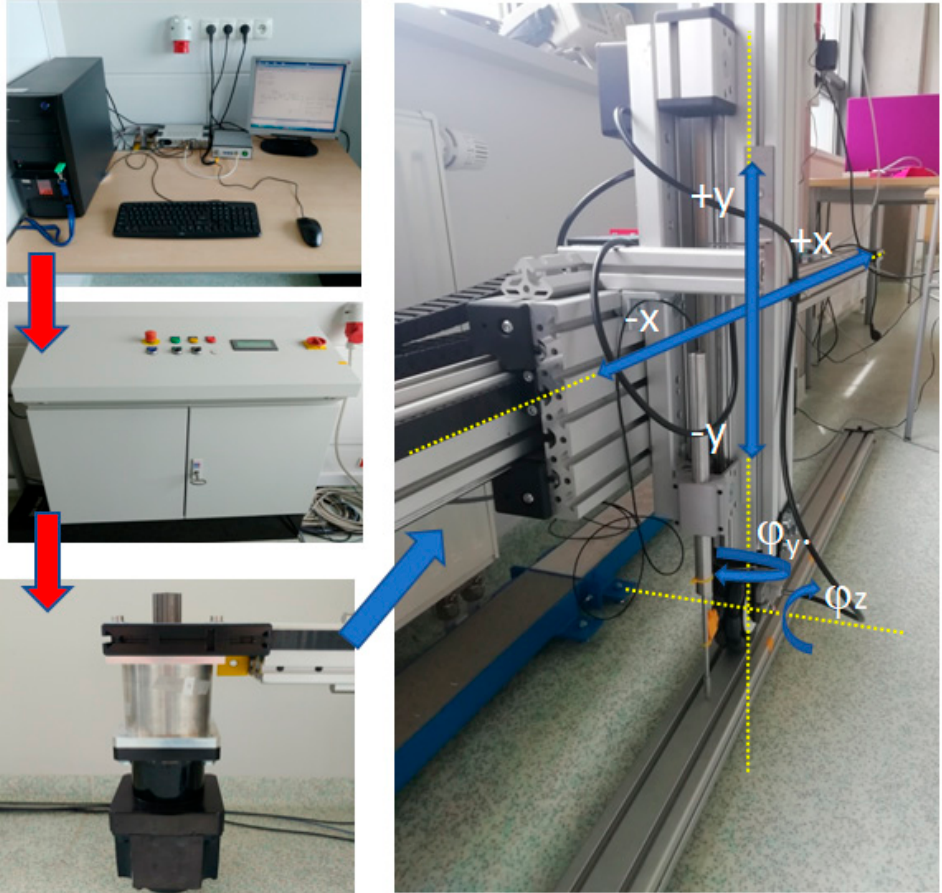
Figure 5. Block diagram showing the connection of the particular components.